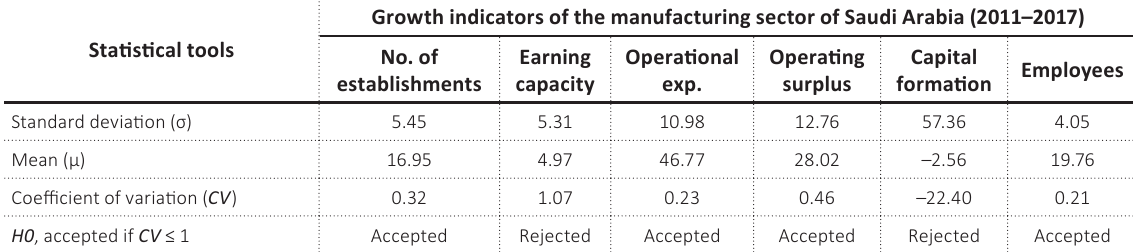
Source: General Authority for Statistics (2011–2017).